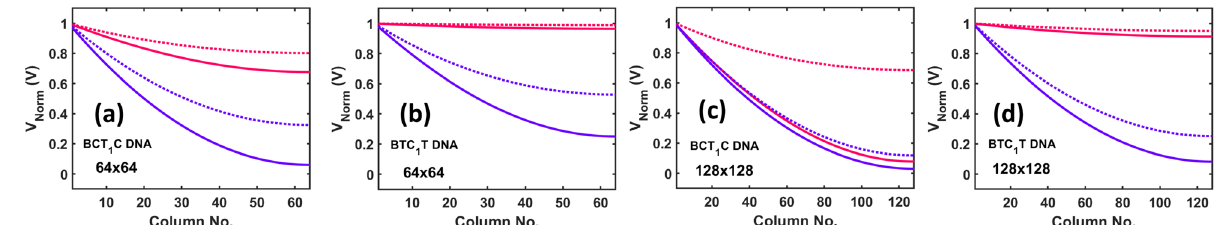
Figure 4. Normalized voltage distribution for homogenous arrays composed of B-CT 1 C DNA ( a , c ) and B-TC 1 T DNA ( b , d ). Array size is 64 × 64 for ( a , b ) and 128 × 128 for ( c , d ). The pink lines correspond to R int = 10 kΩ and the purple lines correspond to R int = 1 MΩ. Moreover, the solid lines represent Fermi energy at corresponding HOMO level while the dotted lines represent Fermi energy at (HOMO + 0.2) eV.